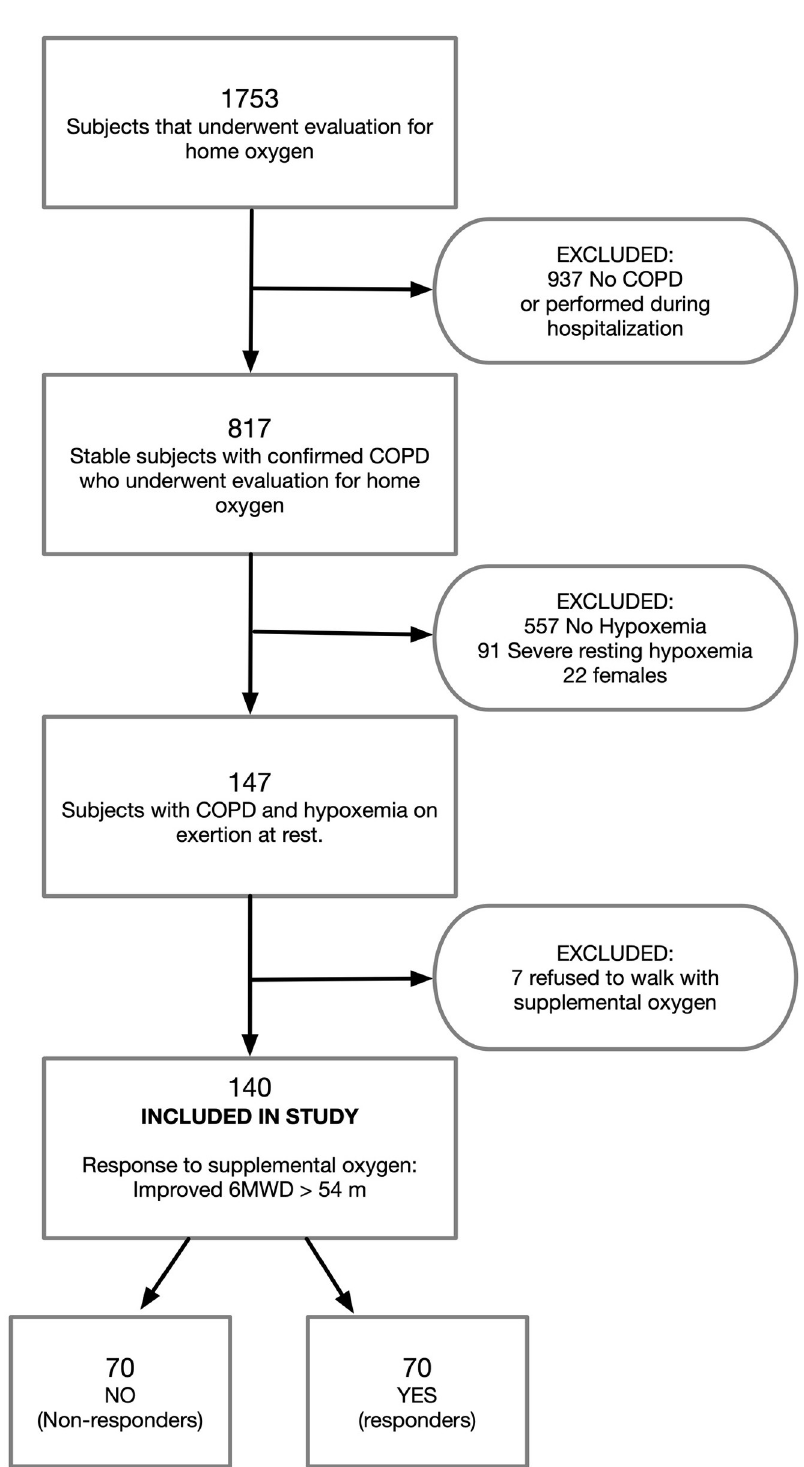
Fig 1. Flow chart detailing how study population was selected from all patients who underwent home oxygen evaluation during the study period.